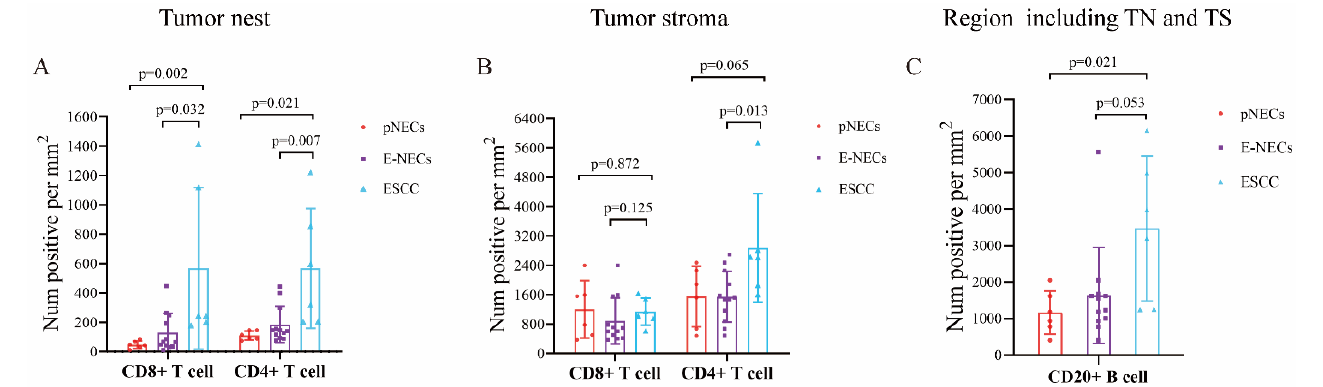
Figure 7. Comparisons of the number of TILs in the TN and TS between E-NECs (including the pNECs subgroup) and ESCC: ( A , B ) comparison of the numbers of CD8 + T and CD4 + T cells in the TN and TS between ESCC and E-NECs; ( C ) comparison of the number of CD20 + B cells between ESCC and overall E-NECs. Abbreviations: E-NECs, esophageal neuroendocrine carcinomas; pNECs, pure neuroendocrine carcinomas; ESCC, esophageal squamous cell carcinoma; TILs, tumor-infiltrating lymphocytes; TN, tumor nest; TS, tumor stroma.